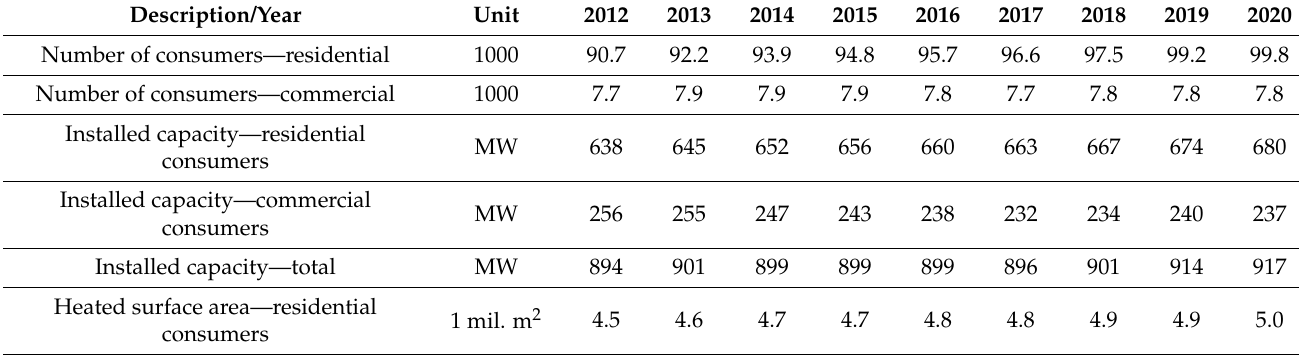
Table 2. Annual balances for the Novi Sad DHS utility company from 2012 to